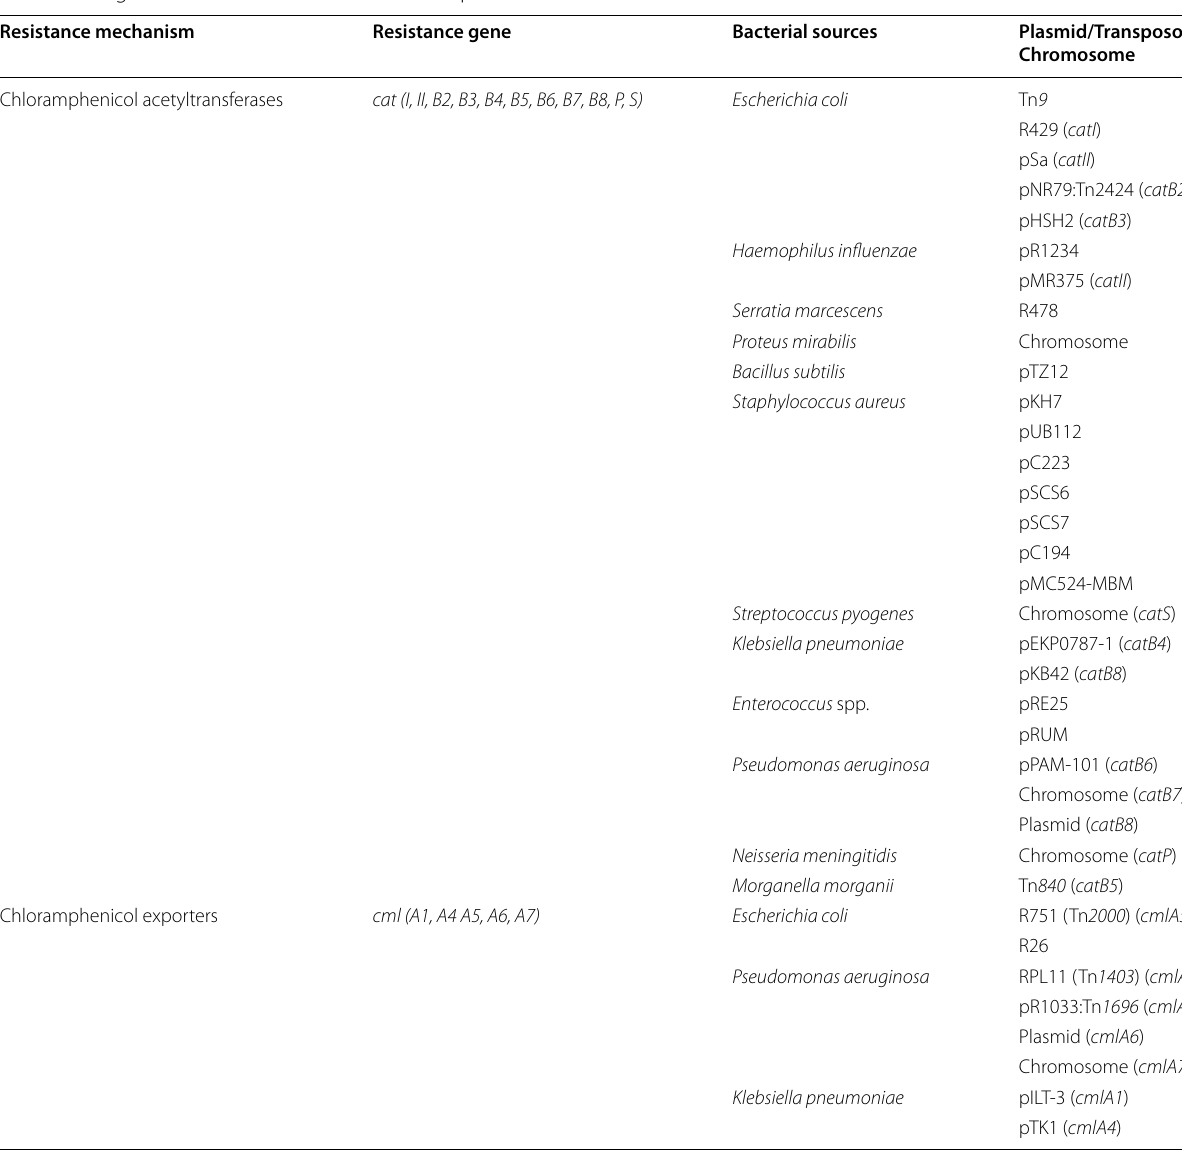
Table 2 Drug resistance mechanisms involved in ophthalmic bacterial infections Resistance